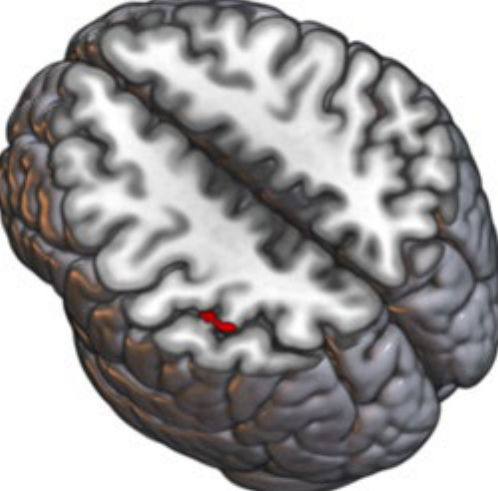
Figure 1. Effect of probiotic intervention on the anatomical structure of the brain. Gray matter of a cluster covering left supramarginal gyrus and superior parietal lobule was significantly ( p < 0.0001) altered upon probiotic intervention. Schematic visualization of the affected brain region (red).